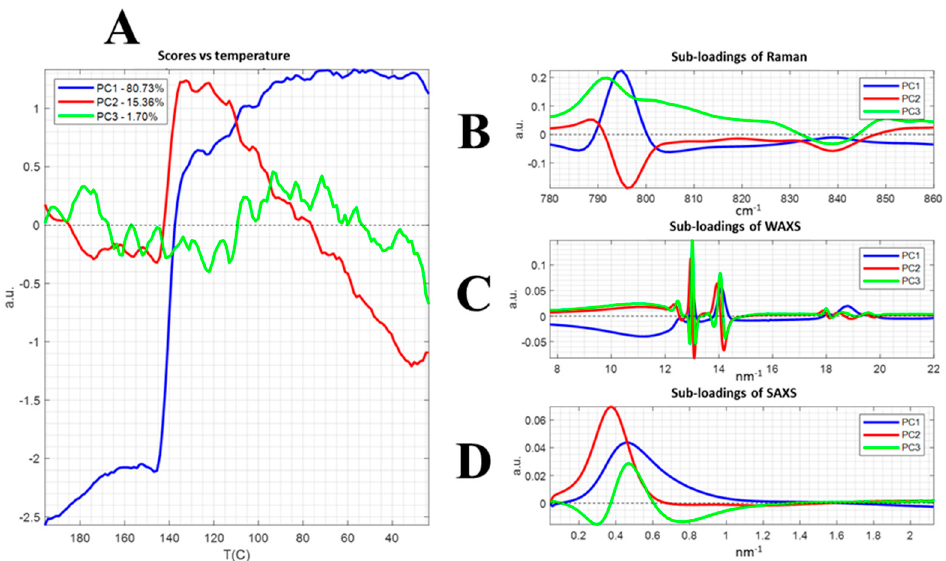
Figure 7. Multiblock PCA. Block-scaled and normalized (mean-centred) PCA model, with the scores as a function of temperature ( A ), the sub-loading of Raman ( B ), WAXS ( C ) and SAXS ( D ).